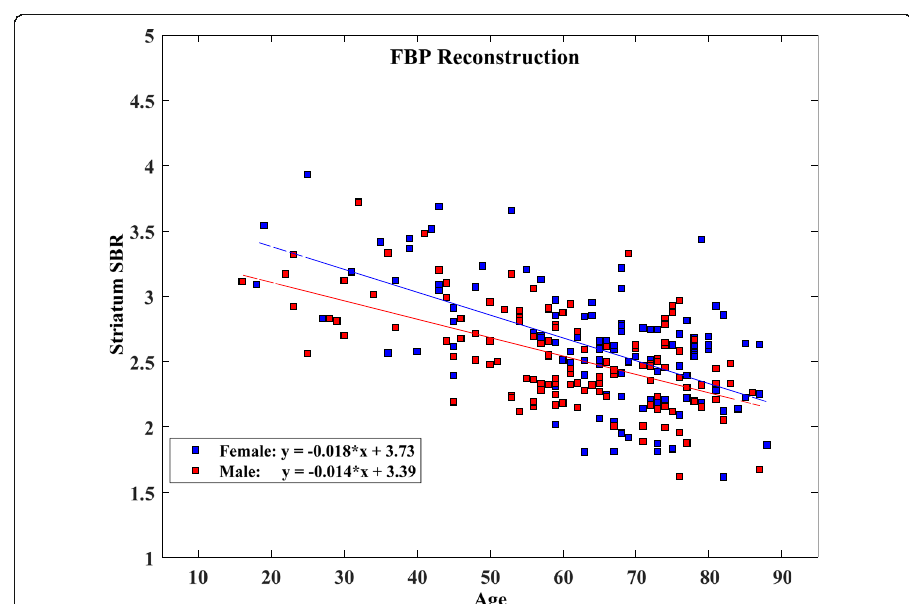
Fig. 4 Effect of age and gender on specific binding ratio (SBR) values computed as the average of left and right SBRs within the striatum and plotted as a function of age. Also shown are regression lines with slope and intercept for the FBP database (female, blue; male, red)